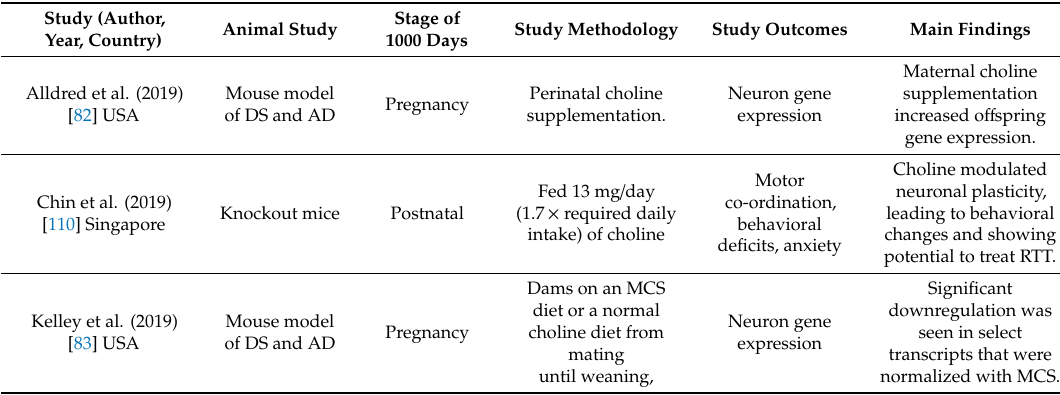
Table 1. Animal studies investigating the inter-relationships between choline, brain function and neurological